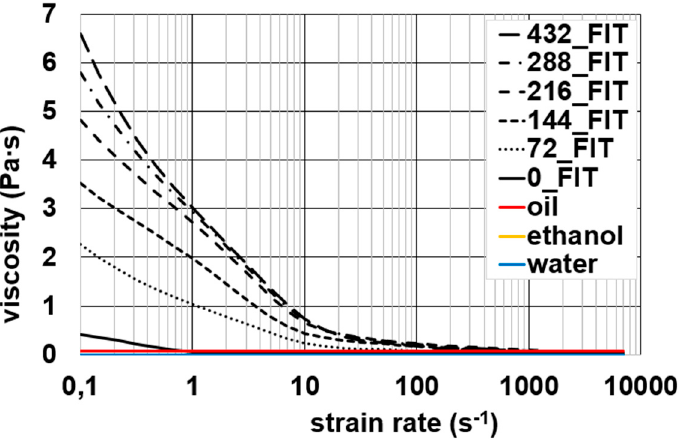
Figure 4. Viscosity dependence on the strain rate for oil, ethanol, water and EMG 900 [5]. Concentrated liquid EMG900 has a strong response in the area of low strain rates (most pronounced up to about 100 s − 1 ), but for high strain rates, the effect of the magnetic field is negligible, and there is even an apparent decrease in the viscosity below its basic value. Both EMG 900 and EMG 905 behave like non-Newtonian fluids under the action of a magnetic